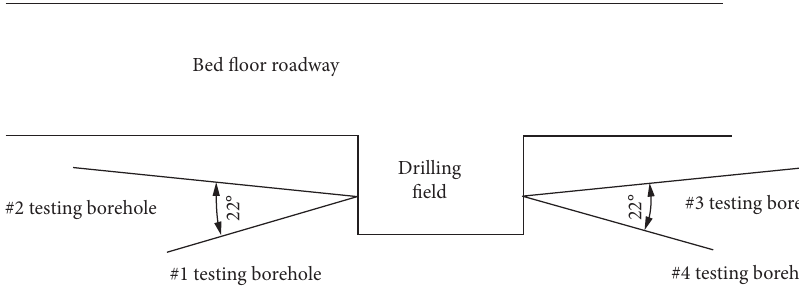
Figure 12: Arrangement of the testing boreholes. Table 3: Parameters of the testing boreholes.